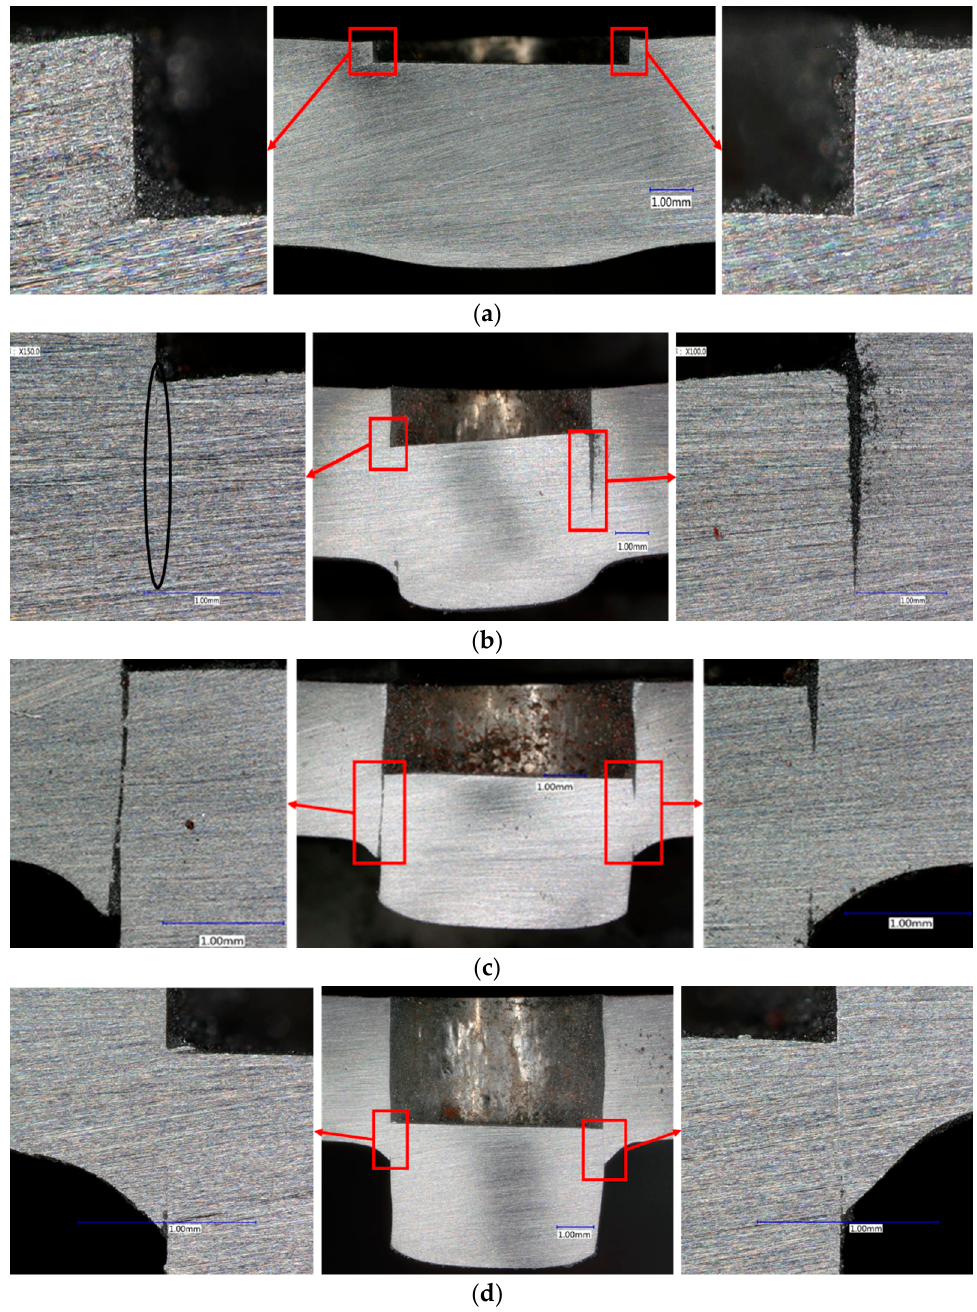
Figure 6. The fracture patterns of the targets under different impact velocities: ( a ) V 0 = 136.6 m/s. ( b ) V 0 = 168.9 m/s. ( c ) V 0 = 170.3 m/s. ( d ) V 0 = 172.9 m/s.